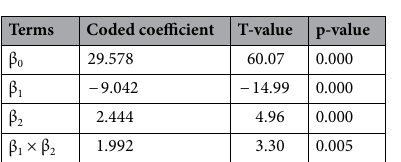
Figure 3. Residual plots for residual peroxidase activity.